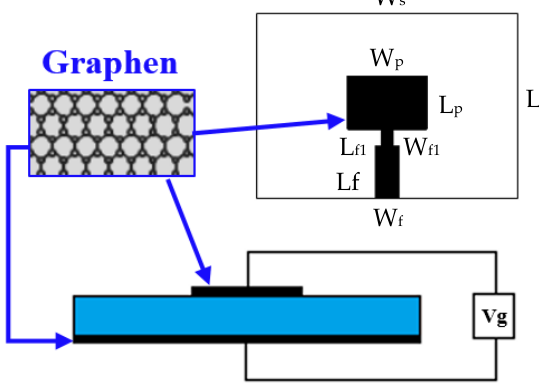
Figure 2. ( a ) Significant and ( b ) characteristic angle of the first four modes of the proposed patch antenna.